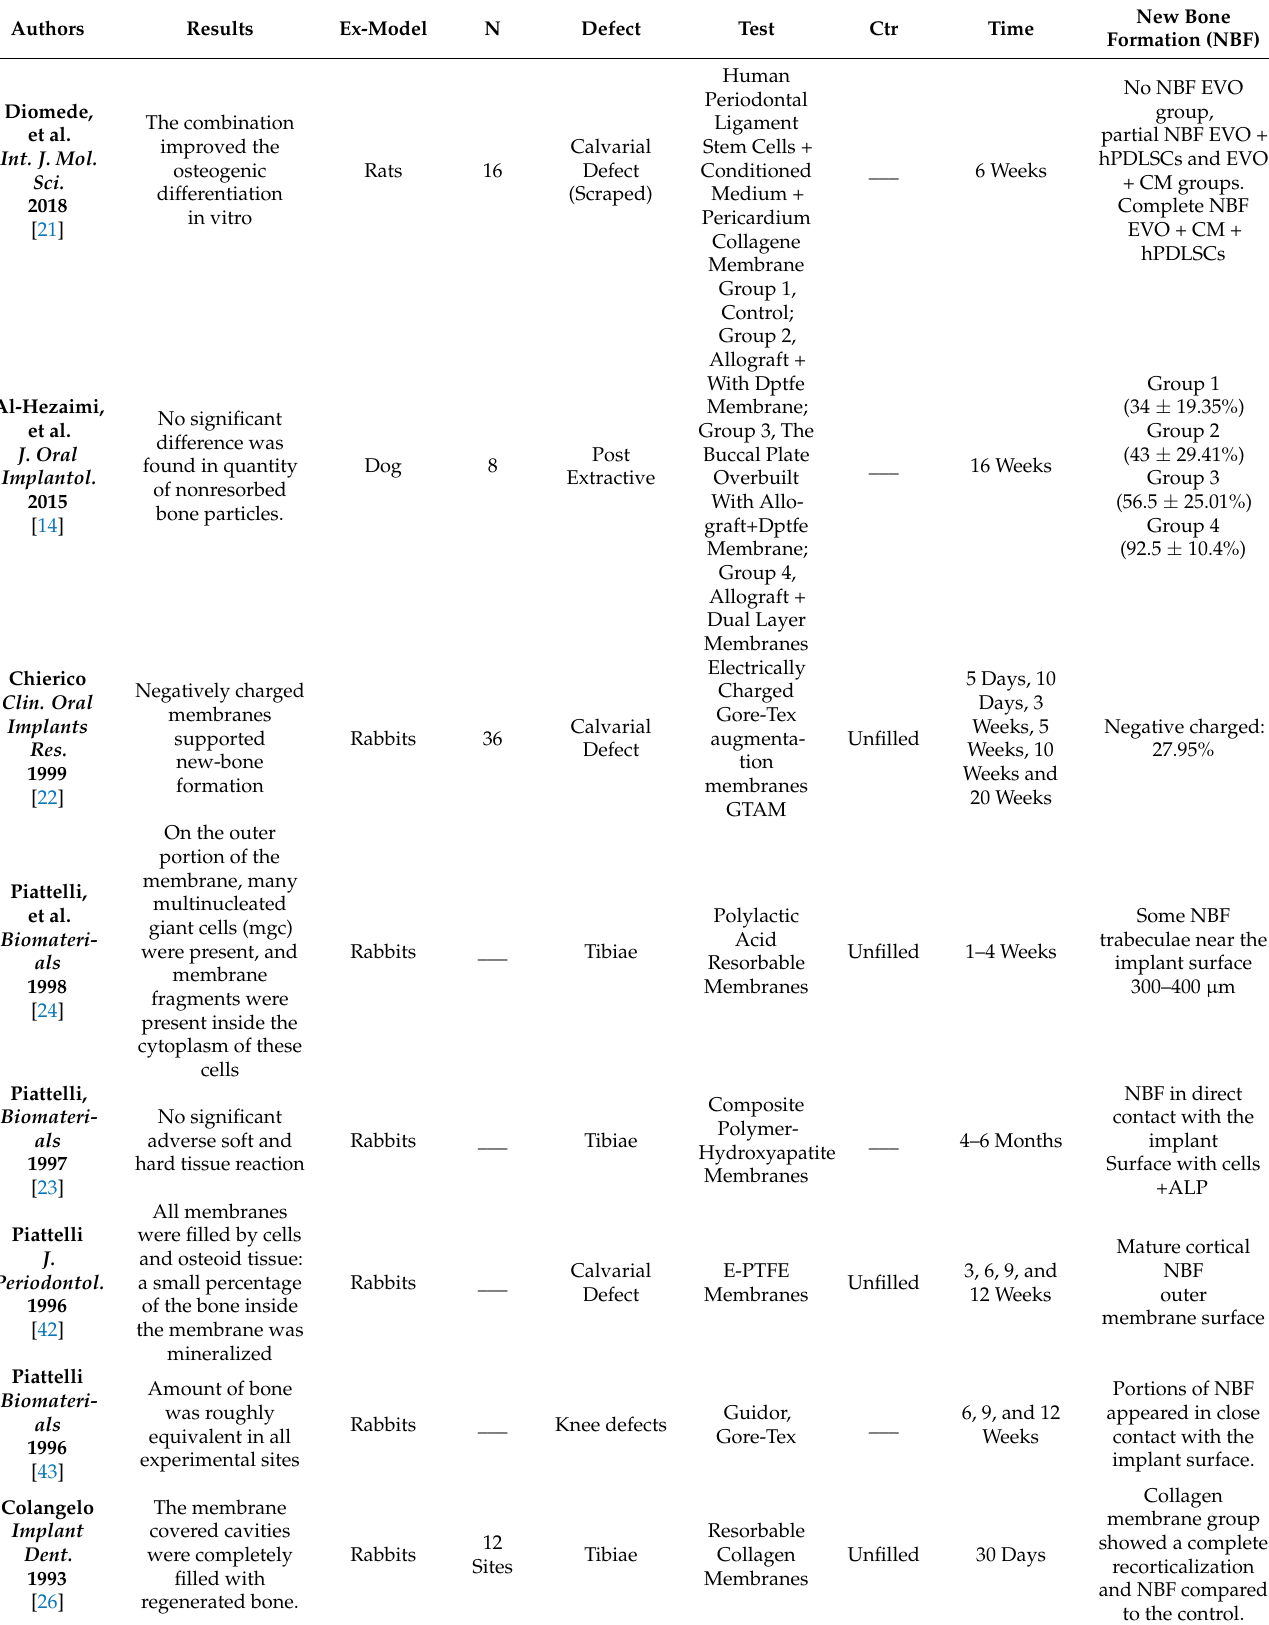
Table 2. Summary of the animal studies